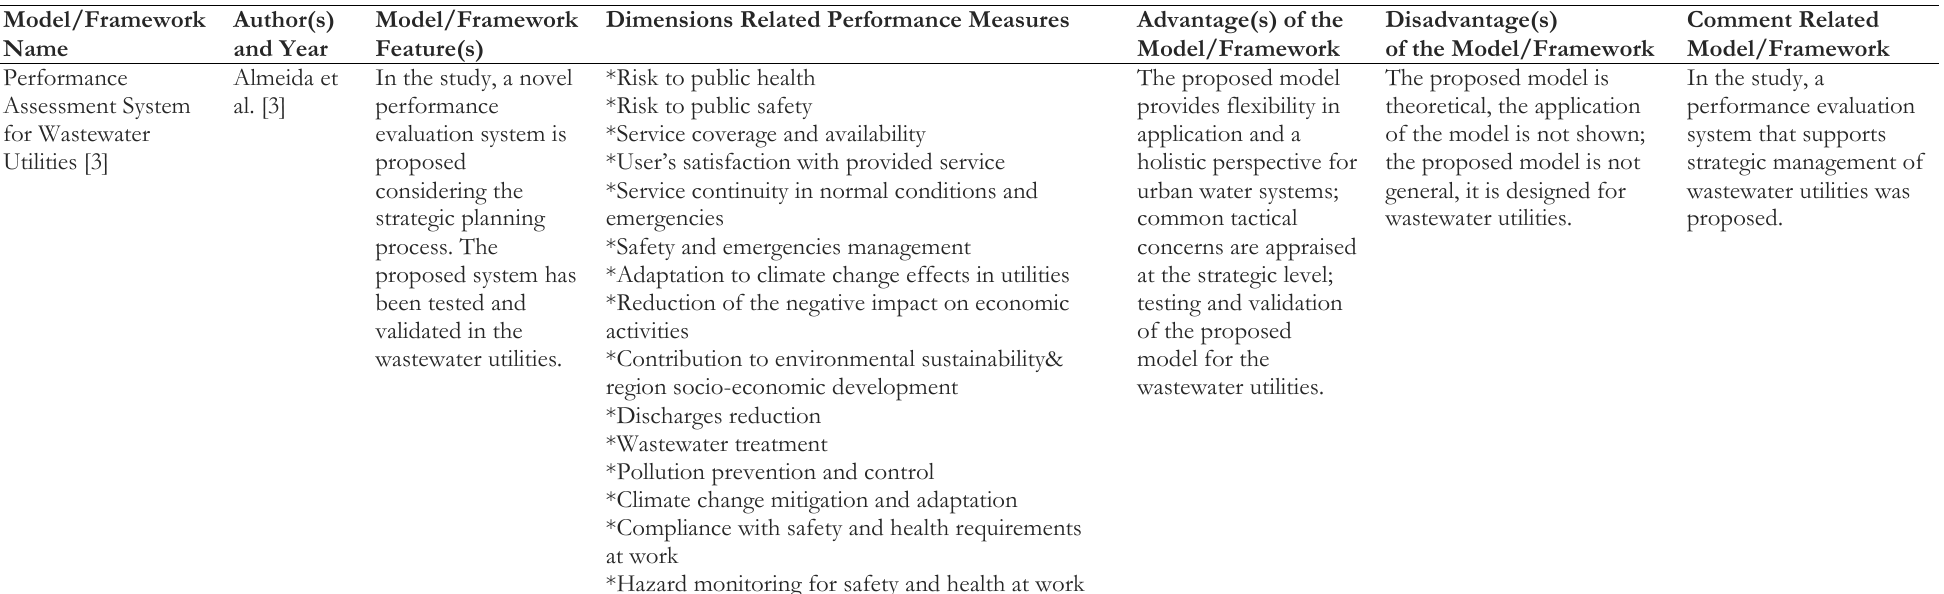
Table 11. Organizational performance measurement models developed in Industry 4.0 period.